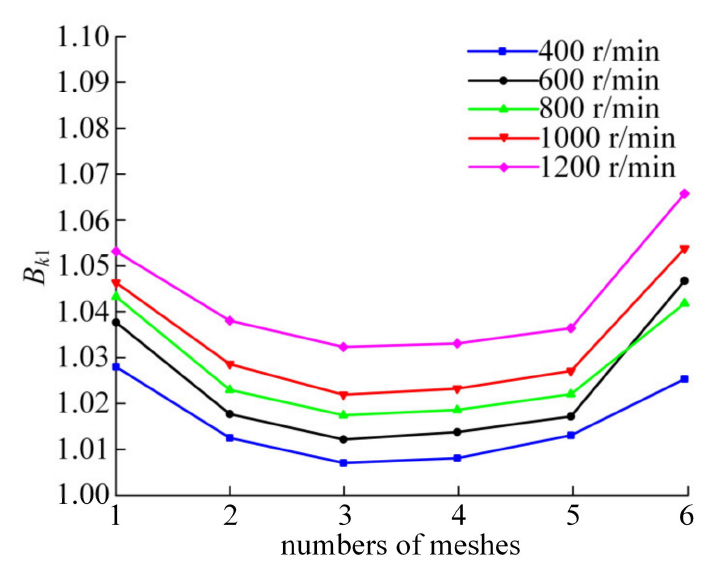
Figure 5. The variation curves of the load proportional coefficient under different input